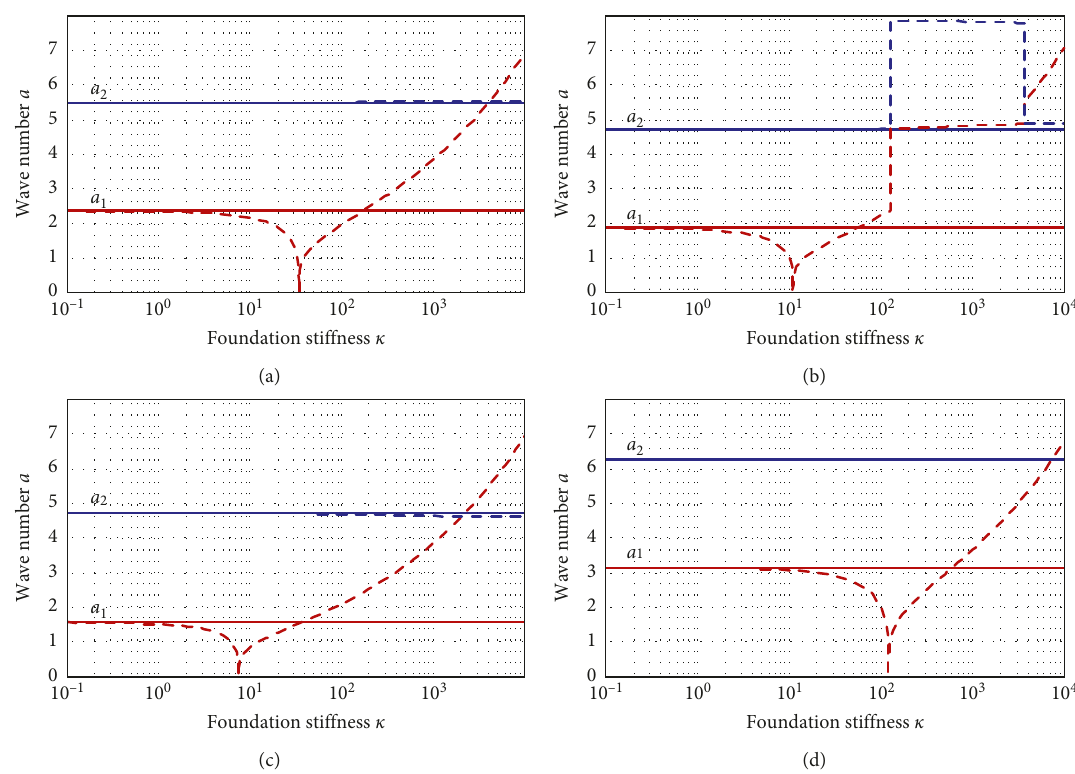
Figure 4: Variations of the first two wave numbers, a and with a movable Winkler foundation (dashed line): (a) Sl-Fi and Fr-Sl, (b) Fr-Fi, (c) Fr-Sl, and (d)